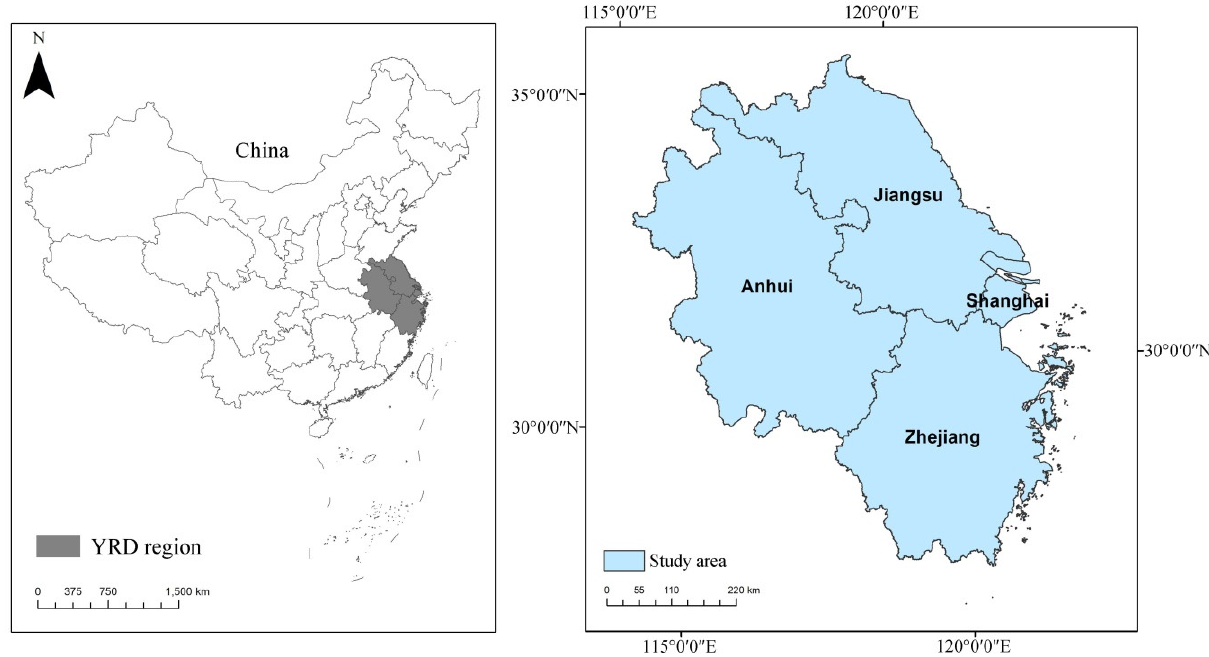
Figure 1. Location of the Yangtze River Delta region. This map was made based on the standard map No. GS (2019) 1822, which was downloaded from the National Administration of Surveying, Mapping and Geoinformation (NASG) of China. The standard map is free to use and does not require copyright instructions. The base map is unchanged, and the geographical coordinate is WGS84.